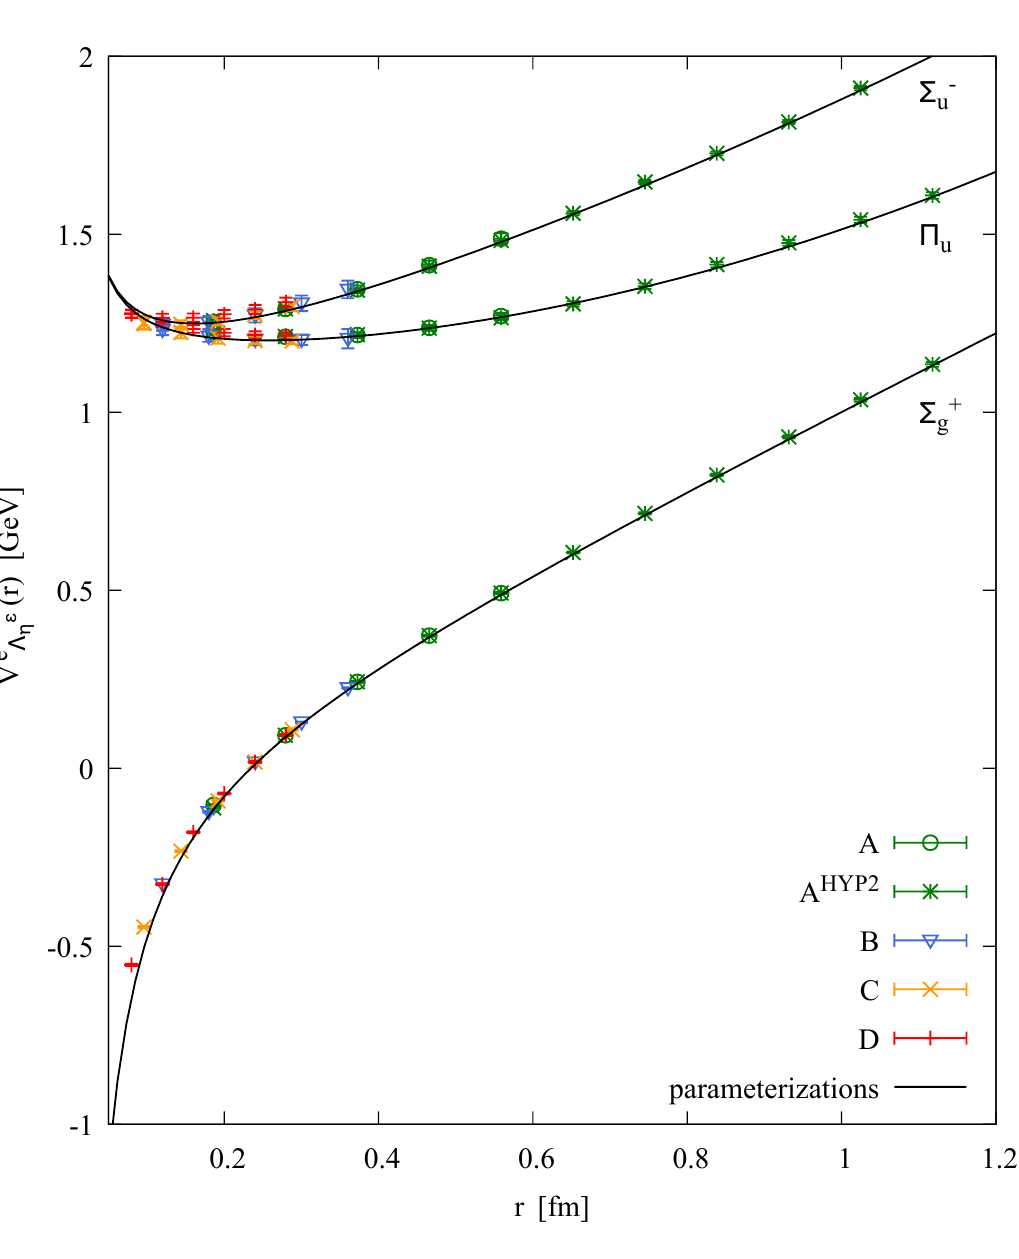
Figure 1: Improved lattice data points (7) and (11) together with the parameteriza- tions (5) and (9) for the ordinary static potential and the Π